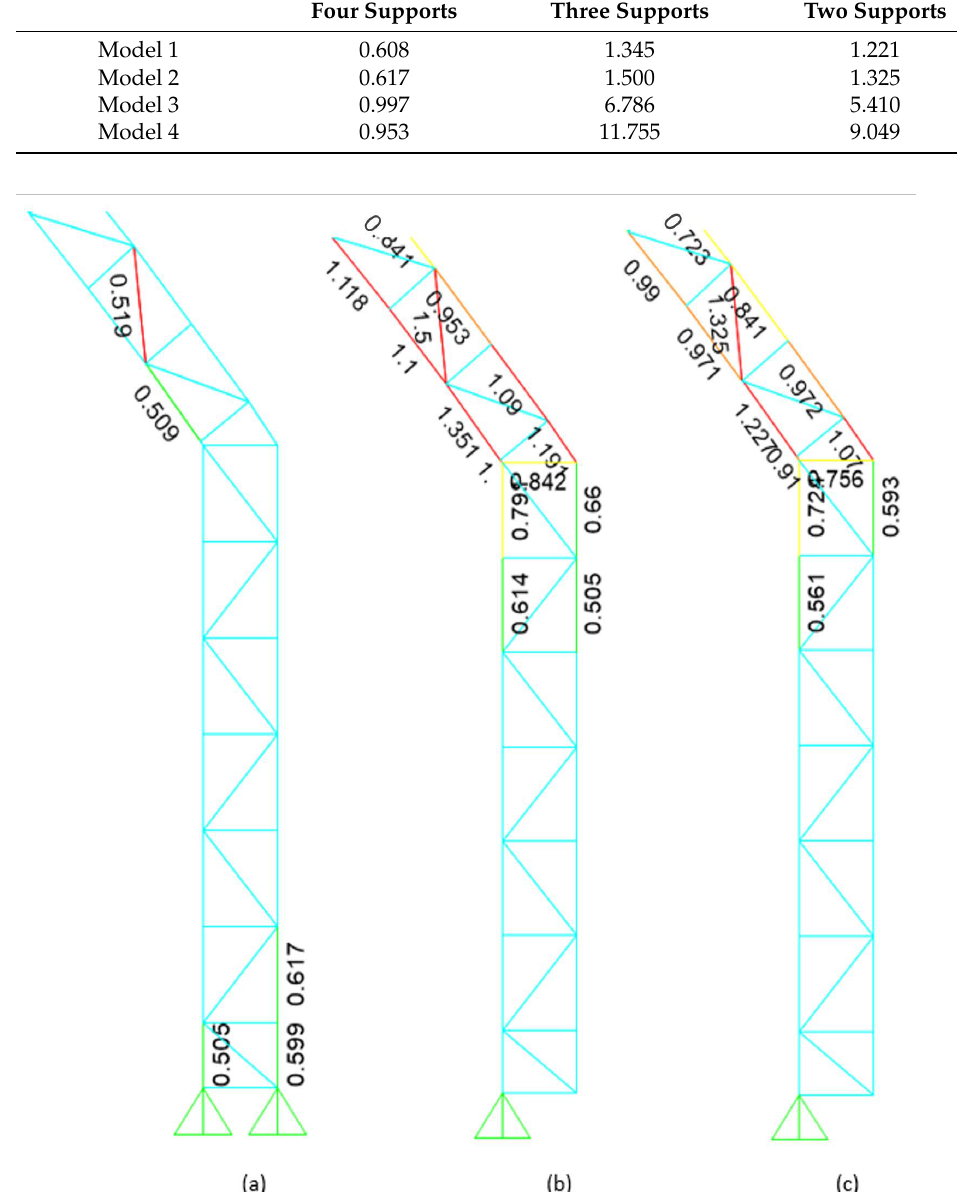
Figure 10. The maximum capacity ratios for Model 2 with ( a ) four supports; ( b ) three supports; ( c ) two